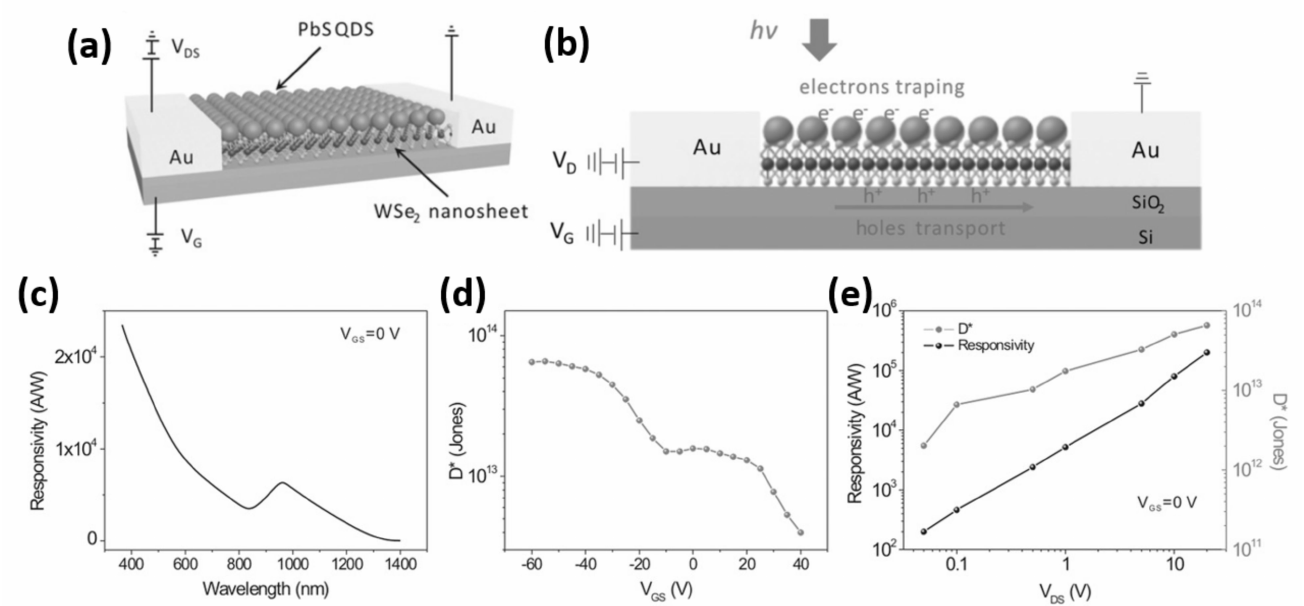
Figure 12. ( a ) Schematic diagram of back-gate WSe 2 phototransistor device capped by PbS QDs. ( b ) Schematic description for the photocarrier transport in hybrid phototransistor under illumination. ( c ) Wavelength dependence response curve of the hybrid phototransistors with V DS = 1 V. ( d ) Specific detectivity as a function of gate voltage at V DS = 1 V. ( e ) Responsivity and detectivity as a function of V DS (V GS = 0 V). [56] Figure reproduced with permission from John Wiley and